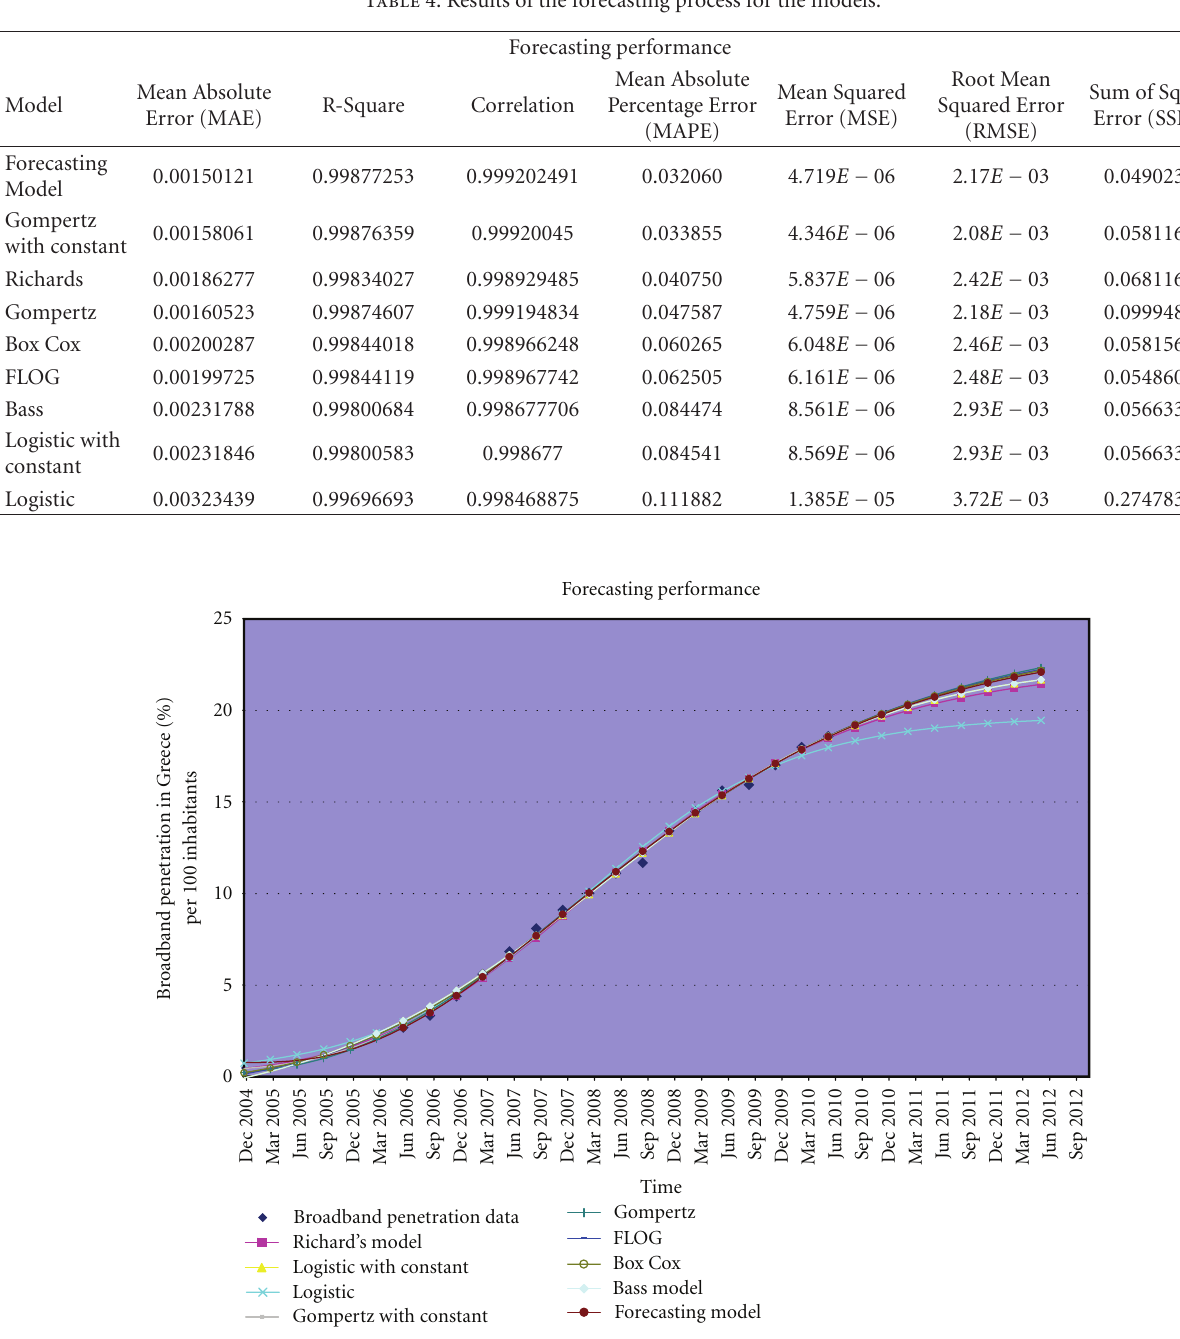
Figure 7: The overall forecasting performance of the